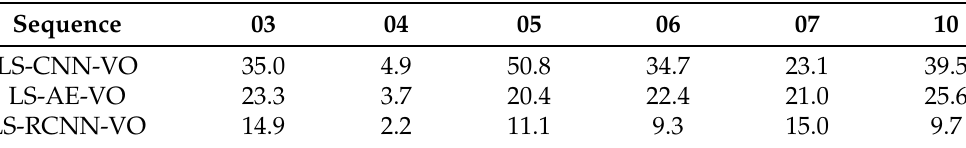
Table 2. Comparison of absolute translation root mean square error (AT-RMSE) (m) of the three models on the KITTI